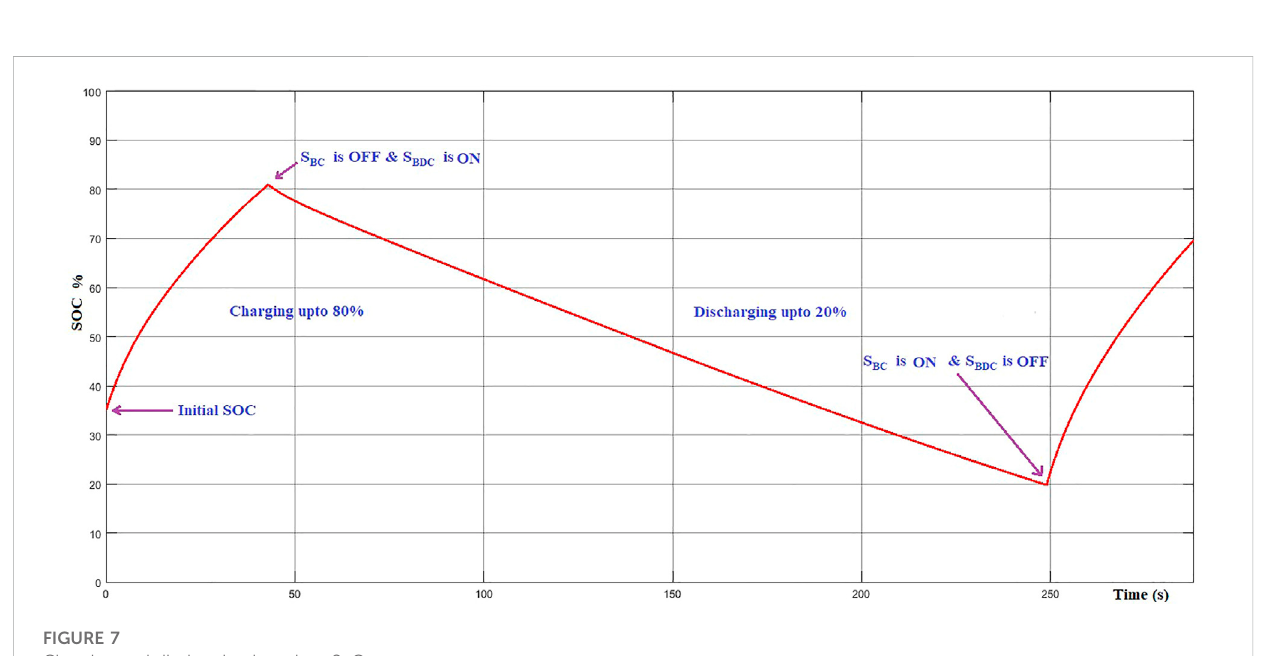
FIGURE 7 Charging and discharging based on